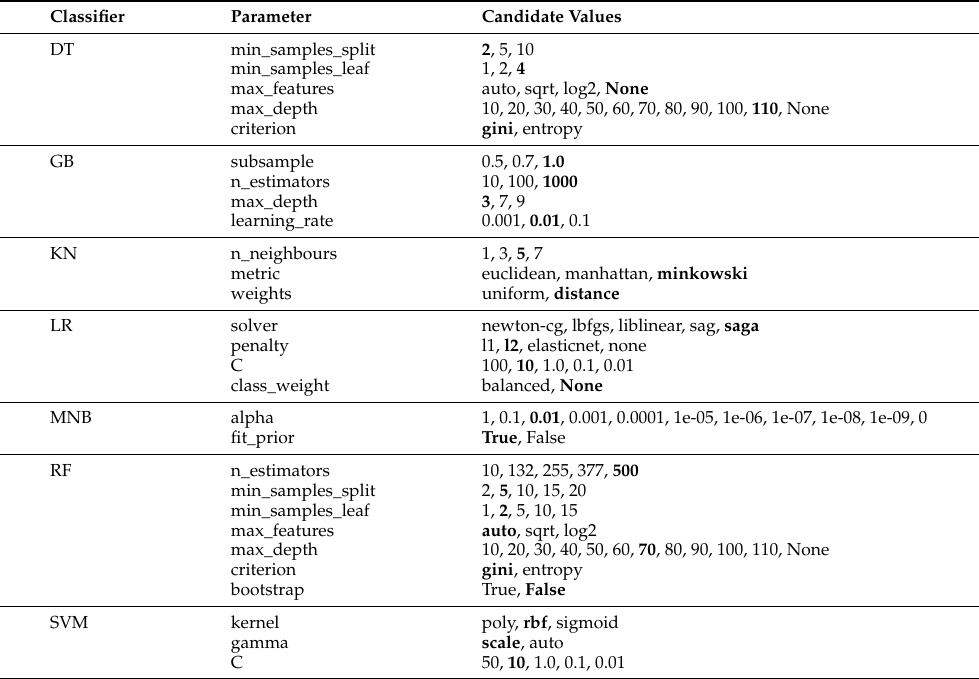
Table 6. In each iteration, a different hyperparameter setting was tried. The hyperparameter settings that yielded the best classification results (by means of the mean F1-score) are shown in bold. Table 6. Values of hyperparameters tried in randomized search.